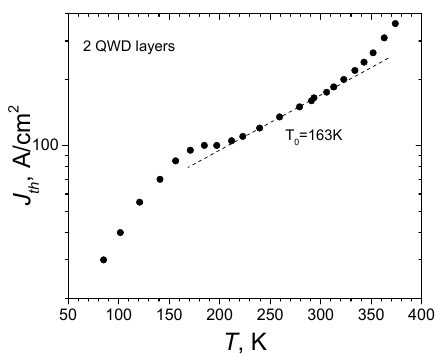
. Figure 12. The dependences of modal gain on the injection current density for devices with different numbers of QWD layers. Figure 13 shows a typical temperature dependence of the threshold current density of a QWD laser. In the temperature range of 220–320 K, the characteristic temperature T 0 is 163 K. Typical characteristic temperatures of QD lasers with undoped active regions are 50–70 K, whereas the use of p -type modulation doping of active region allows one to increase it above 1000 K [60]. The characteristic temperature of the QW lasers typically slightly exceeds 100 K [70]. Note that QWD active region was undoped. Thus, the temperature stability of QWD lasers is comparable with the best QW lasers and exceeds that in QD lasers with the undoped active region. In the temperature range of 120–200 K, the temperature dependence of the threshold current shows an N-shape [71], which can be explained by the presence of QDs in a joint QWD/QD array in the laser-active region (Section 3.1), when temperature increases above 100–150 K, the carriers start